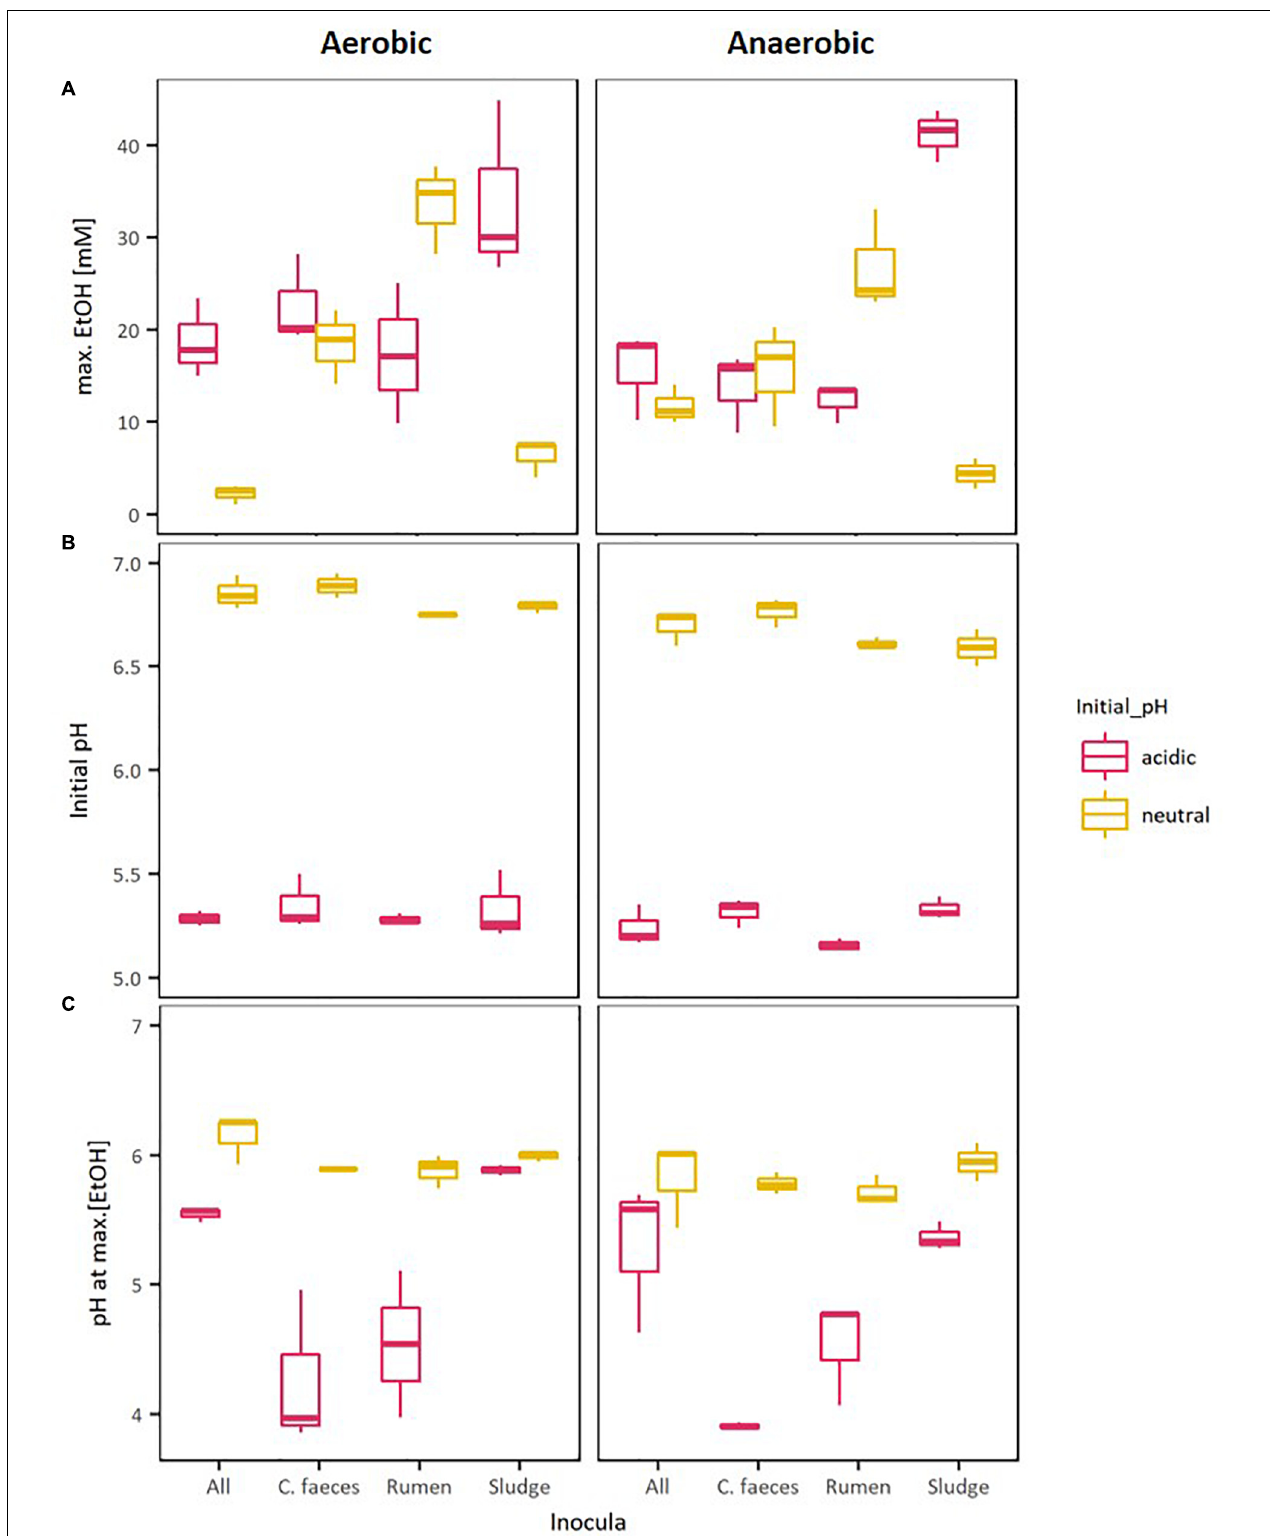
FIGURE 2 | Boxplots of: (A) maximal EtOH production by the different inocula tested in initially acidic and neutral pH, (B) their initial pH, and (C) their pH at max. EtOH concentrations.